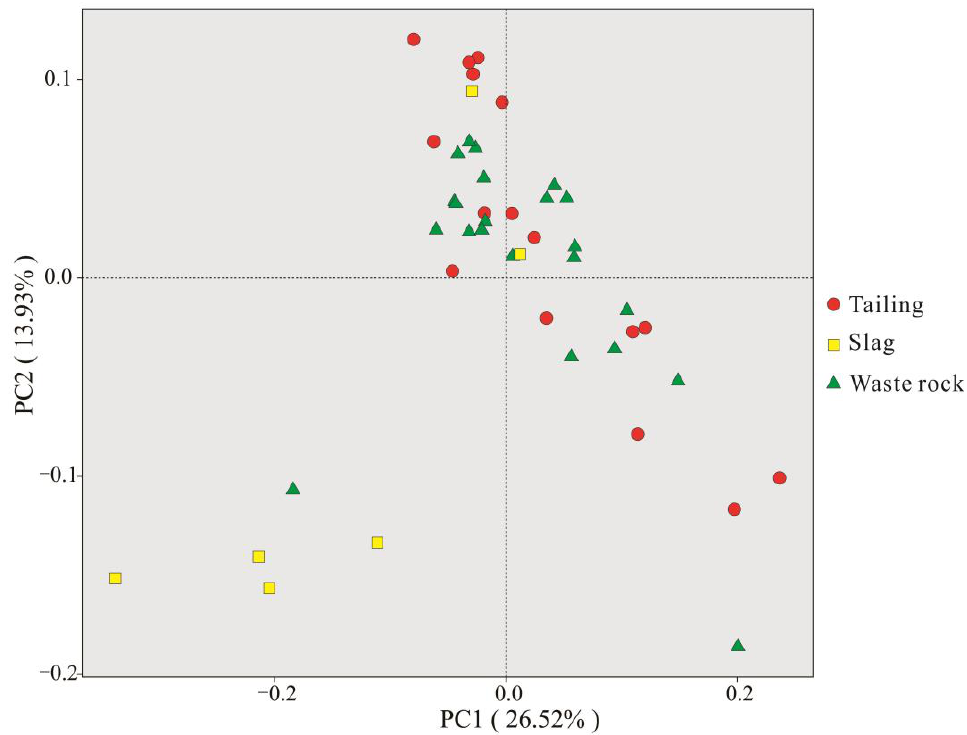
Figure 7. Analysis of the principal coordinates of the rhizosphere microbial OTUs of three mine waste plants.